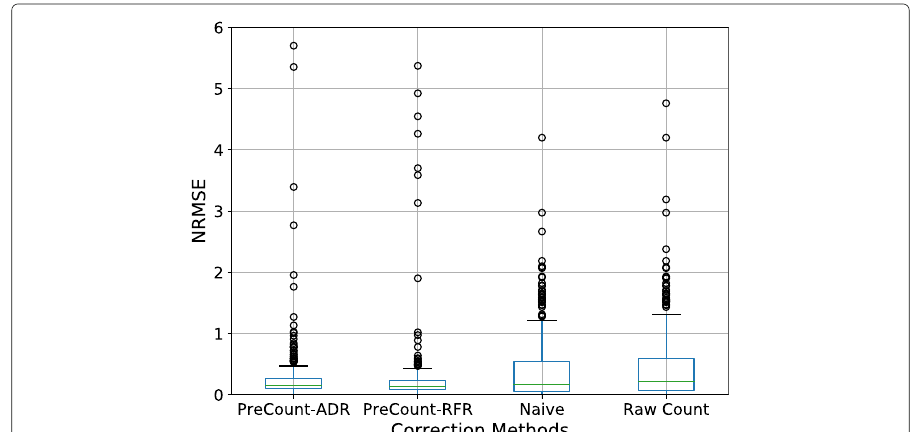
Fig. 8 Boxplot showing the performance of each correction method for LIBRARY building case